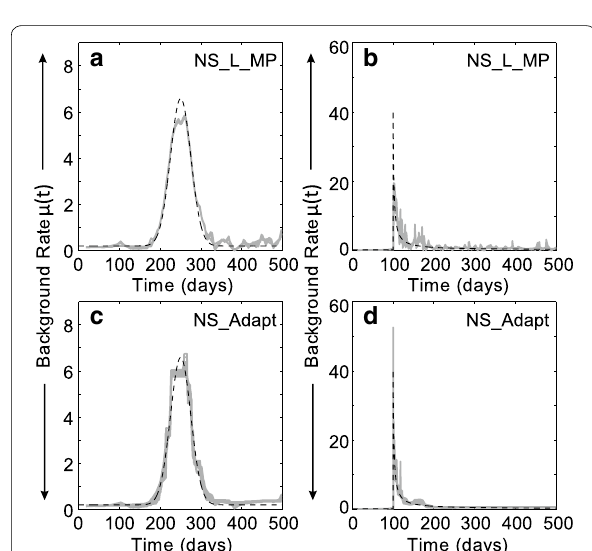
Fig. 5 Background rates of each kind of synthetic catalogs esti- mated using different number of splines M and M τ . The estimated background rate function using all possible combinations of M = { 50,100,150,200,250,300 } and M τ = { 10,20,30,40,50,60 } such that M τ < M , estimated using the models NS_L_MP and NS_Adapt for a typical Gaussian synthetic catalog are, respectively, shown in ( a , c ). These plots for a typical Omori’s law-type synthetic catalog are presented in ( b , d ). The true background rate functions (dotted line) are also